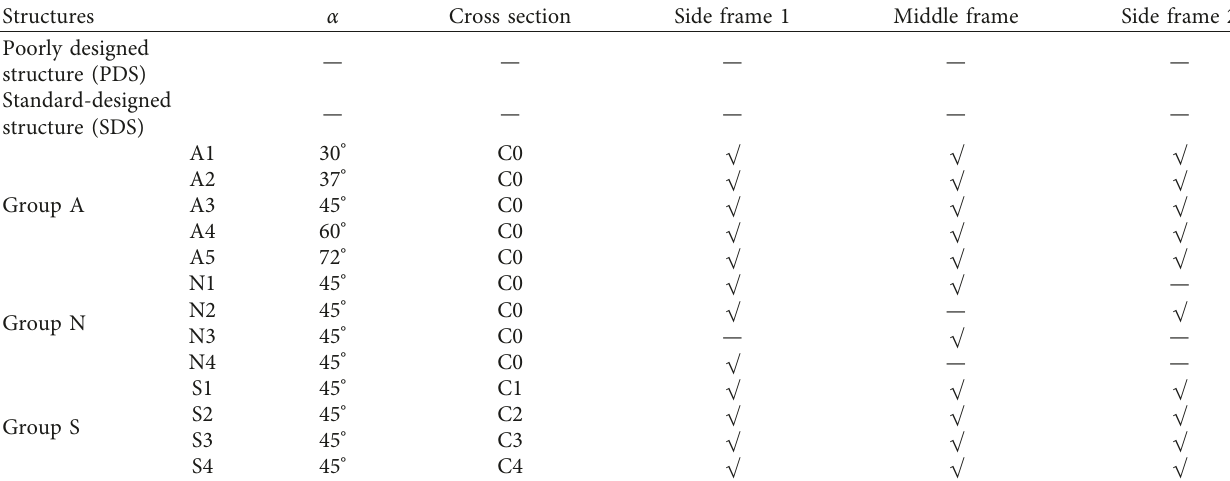
Table 2: Support schemes and the parameters of the fragility